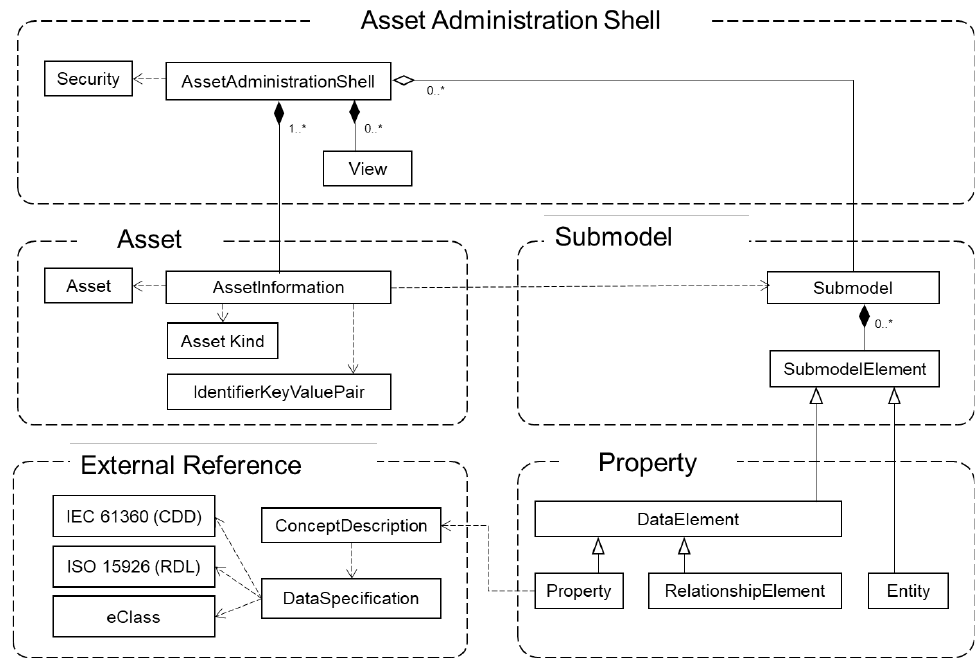
Figure 4. Meta-data model of AAS.